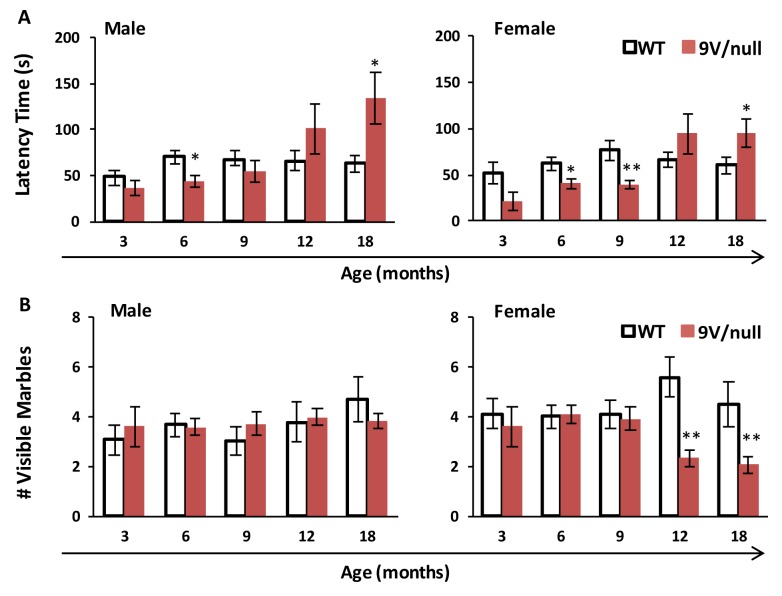
Anxiety-like marble burying behavior in 9V/null mice.Mice were exposed to an arena with 15 blue marbles for 30 min. The test was repeated multiple times from 3 to 18 months of age. A: Latency to initiate burying. B: Number of visible marbles. 9V/null group had a shorter latency to initiate burying activity at 6 months of age, but the latency increased significantly starting at 12 months of age. 9V/null female mice buried significantly more marbles to completion than the WT group. *, p<0.05; **, p <0.01 (n = 8–10 mice for 3 months groups, and n = 12–20 mice for other age groups) by Student’s t-test.